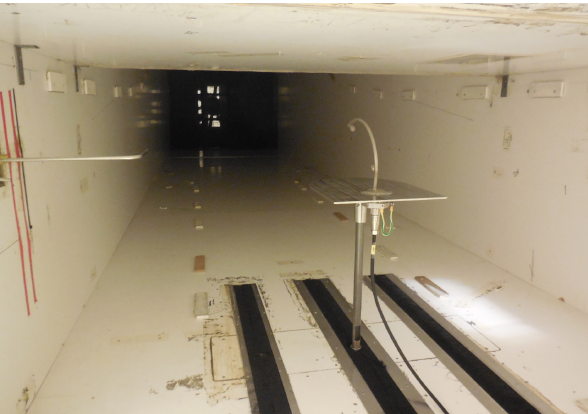
Figure 3. One sonic sensor mounted on the mounting plate in the test section of the SOHansen wind tunnel. The reference pitot tube is visible at the left-hand side of the